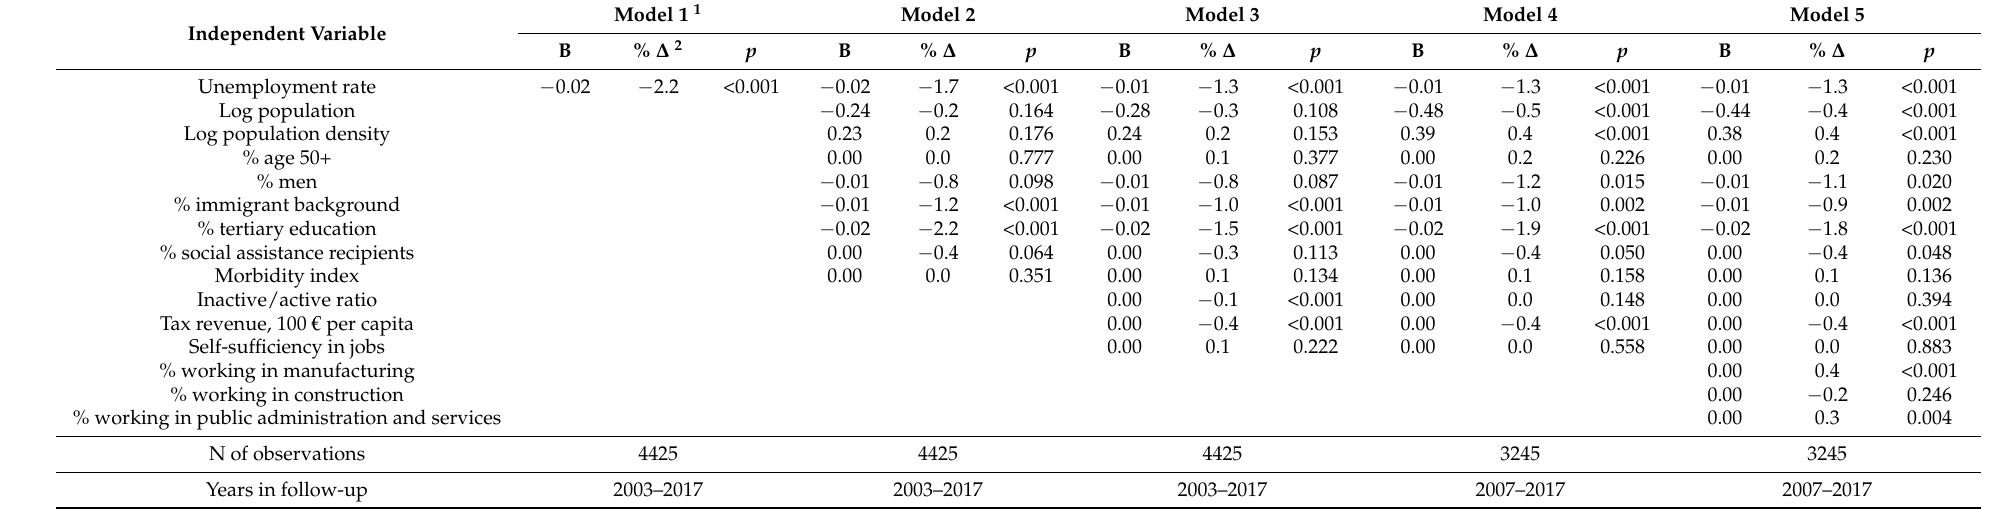
Table 3. Results on sickness absence (logged sickness absence rate as outcome). Fixed effects models on Finnish municipalities ( n = 295) over 15 years (2003–2017). Independent